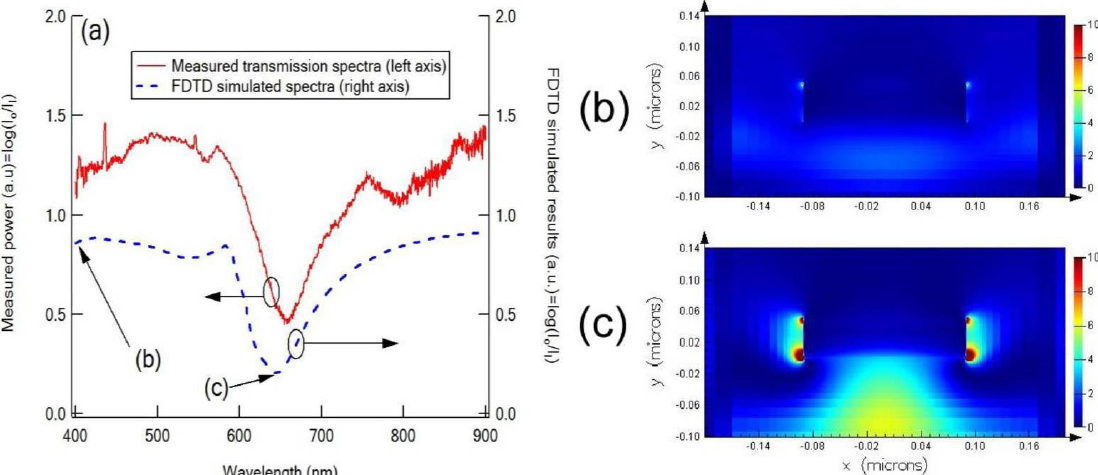
Figure 27. ( a ) The measured and simulated transmission spectra for the nanodot array in air; ( b , c ) intensity of the electric field around the nanodots for 400 nm and 650 nm, respectively. Reprinted with permission of